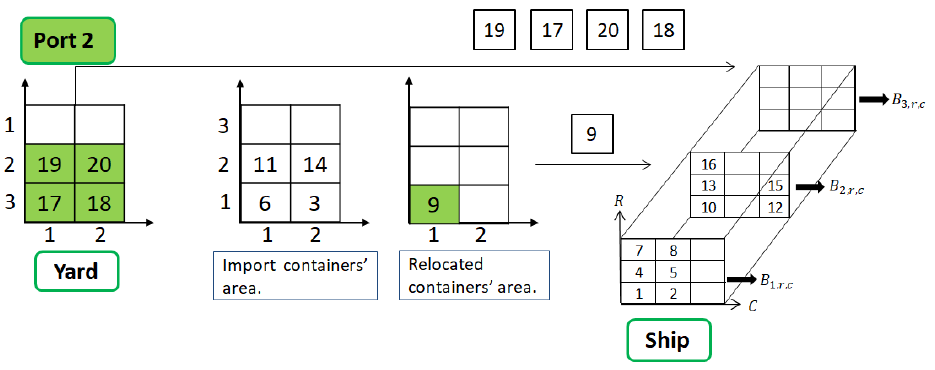
Figure 3. Loading flow at port